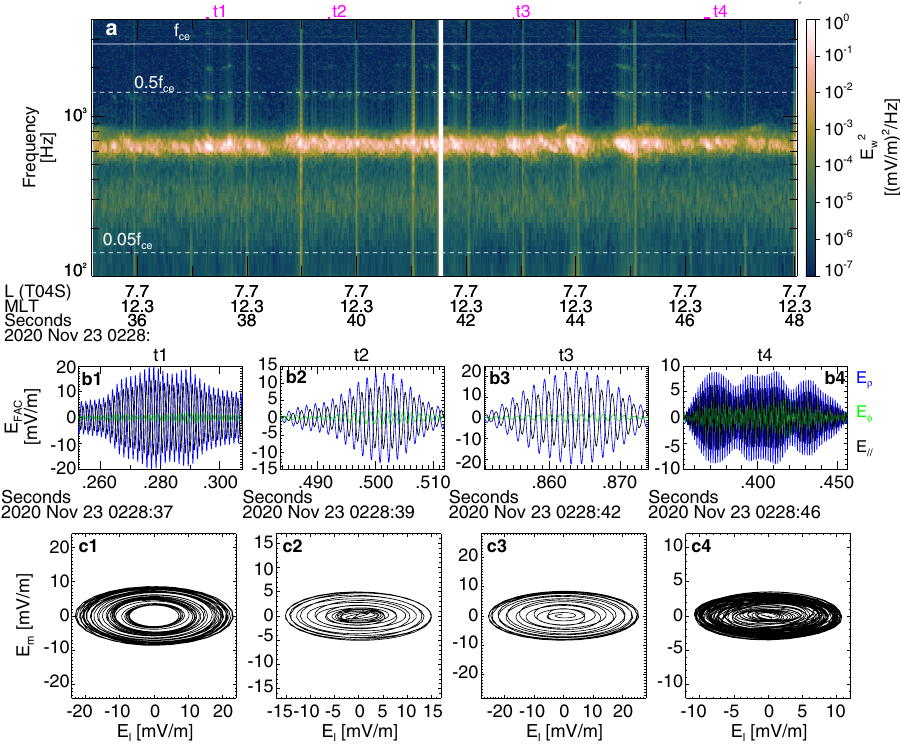
Fig. 4 Whistler-mode wave characteristics as observed by THEMIS-E spacecraft. a Whistler-mode wave electric fi eld spectra, four examples (at times corresponding to t1 – t4 denoted by magenta bars in panel a) of wave packets with b electric fi elds in local geomagnetic- fi eld-aligned coordinates and